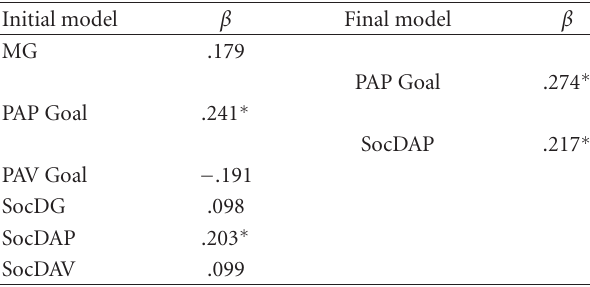
Table 4: Summary of stepwise regression analysis using backward elimination approach for academic achievement goals, social goals, and hedonic enjoyment.